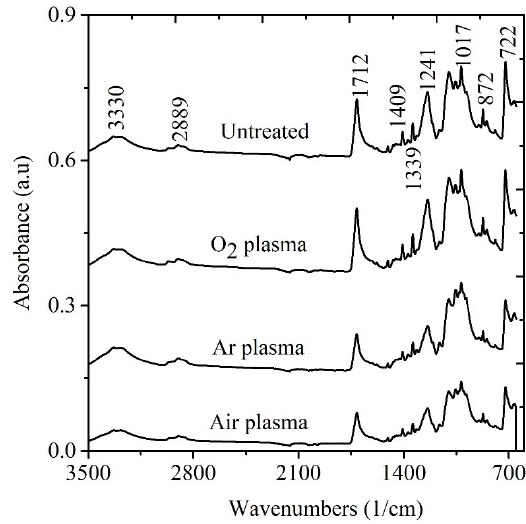
Figure 7. ATR-FTIR spectra of plasma treated and untreated P/C blend